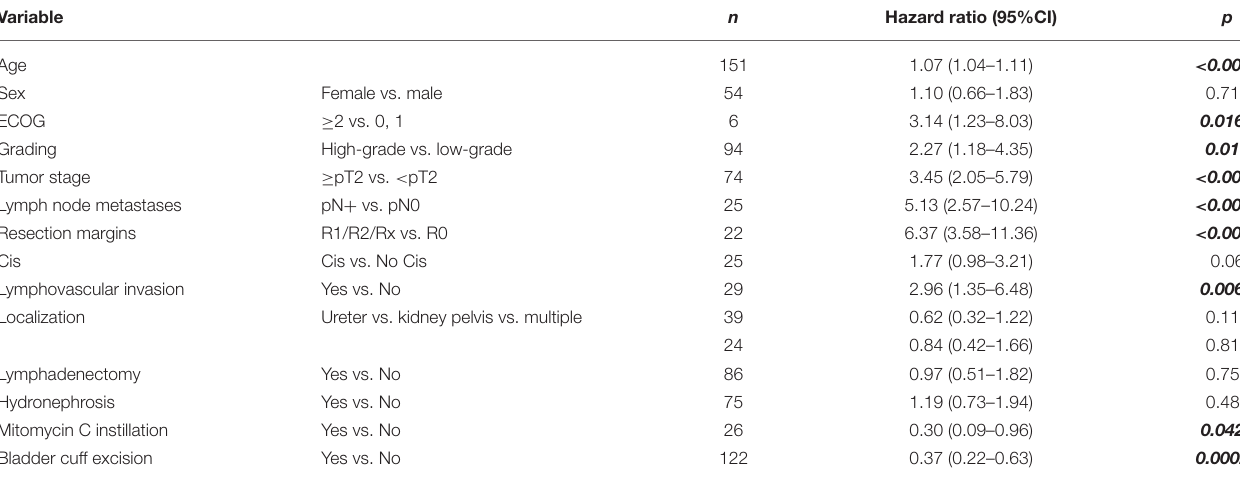
TABLE 2 | Univariate Cox-regression model for overall